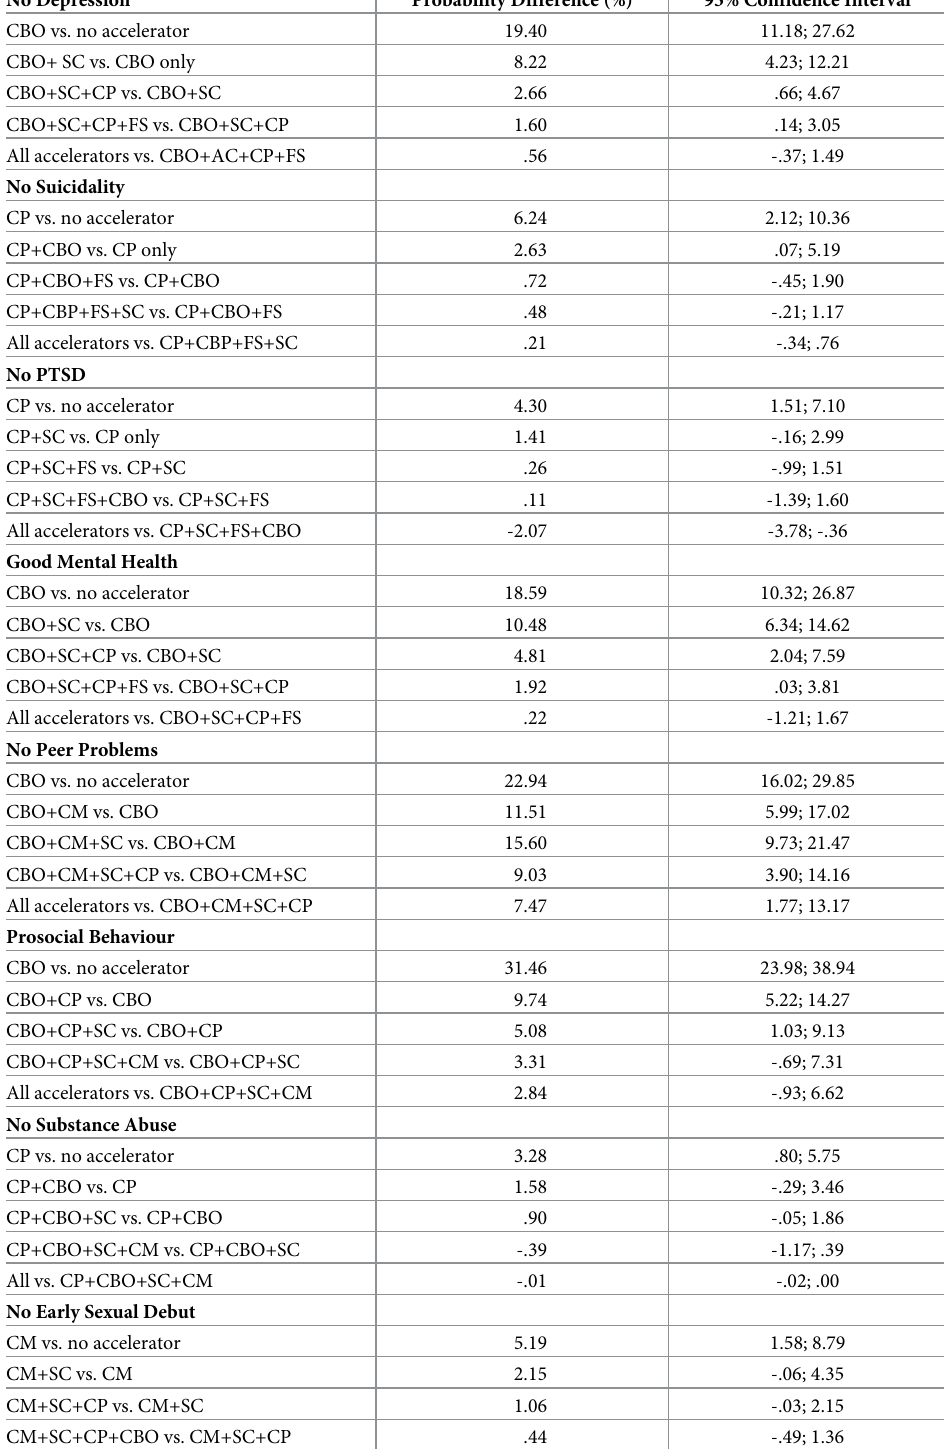
Table 2. Summary of relative change in outcome probabilities conditional on incremental combinations of pro- tective